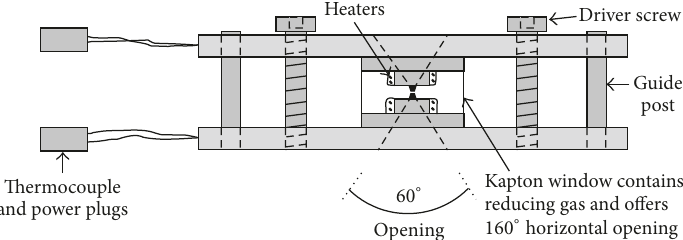
Figure 6: A schematic drawing of the type V hydrothermal diamond-anvil cell [24,